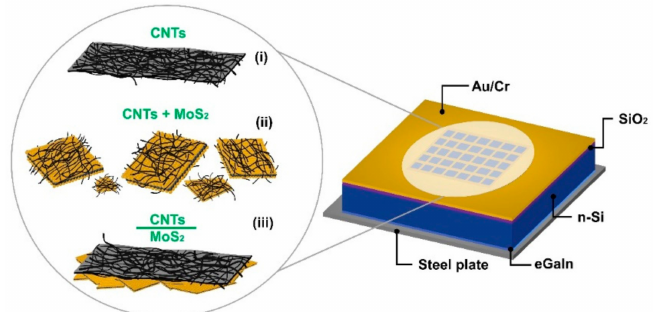
Figure 1. Structures of devices made in this work. All devices involve putting a thin films of various materials on the silicon. ( i ) single wall carbon nanotubes (SWCNTs) only; ( ii ) SWCNT + MoS 2 hybrids; and ( iii ) a layer of MoS 2 with a SWCNT layer placed on